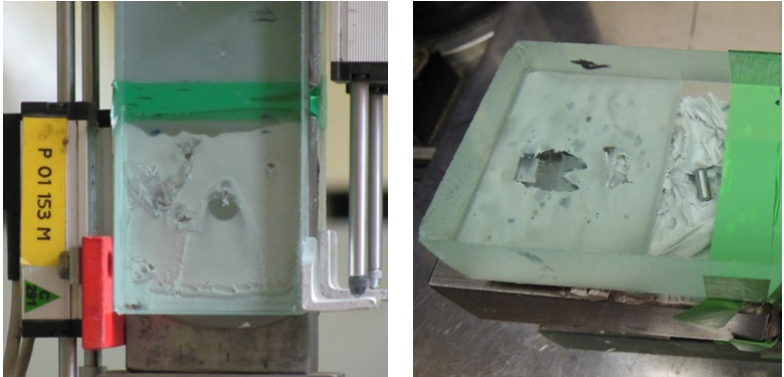
Fig. 5 SikaFast-5211 failure mode. Fig. 6 SikaFast-5211 NT failure